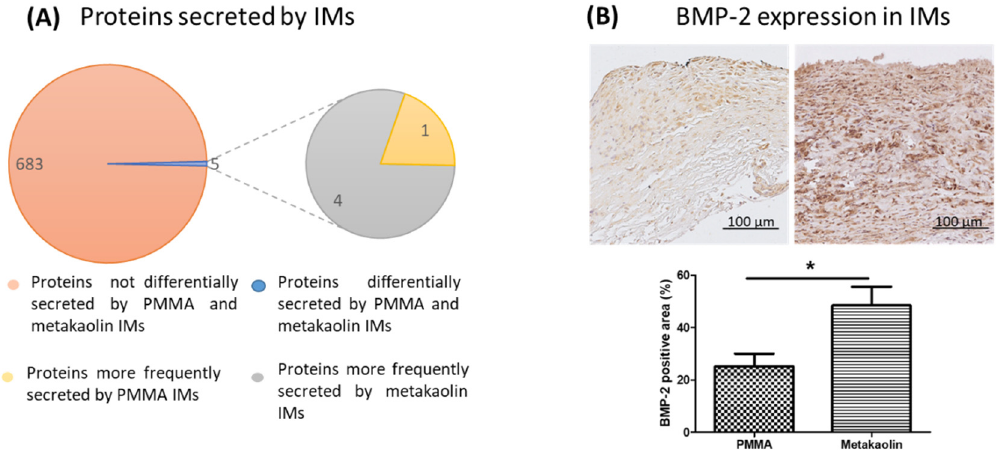
Figure 4. ( A ) Secretome profiles of PMMA-IMs and metakaolin-IMs. In total, 683 proteins with similar frequencies of secretion in the PMMA and metakaolin groups were identified by mass spectrometry. By contrast, five proteins were differentially secreted: four proteins were more frequently secreted by the metakaolin-IMs, and the other was more frequently secreted by PMMA-IMs. ( B ) Representative histological slide of in situ BMP-2 immunostaining in PMMA-IMs (left panel) and metakaolin-IMs (right panel). The diagram shows the percentage of the area of the collected membranes positive for BMP-2; * p < 0.05.